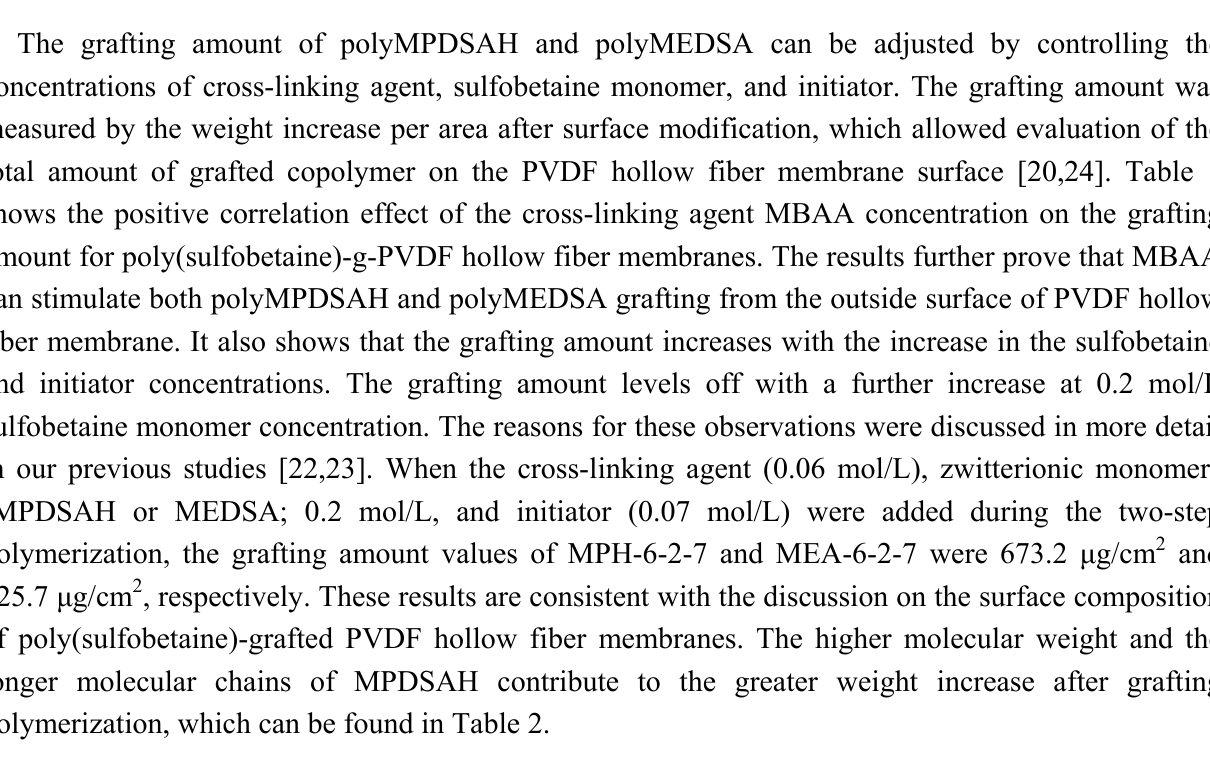
Table 1. Grafting amount, mean pore size, and membrane strength of various membranes.